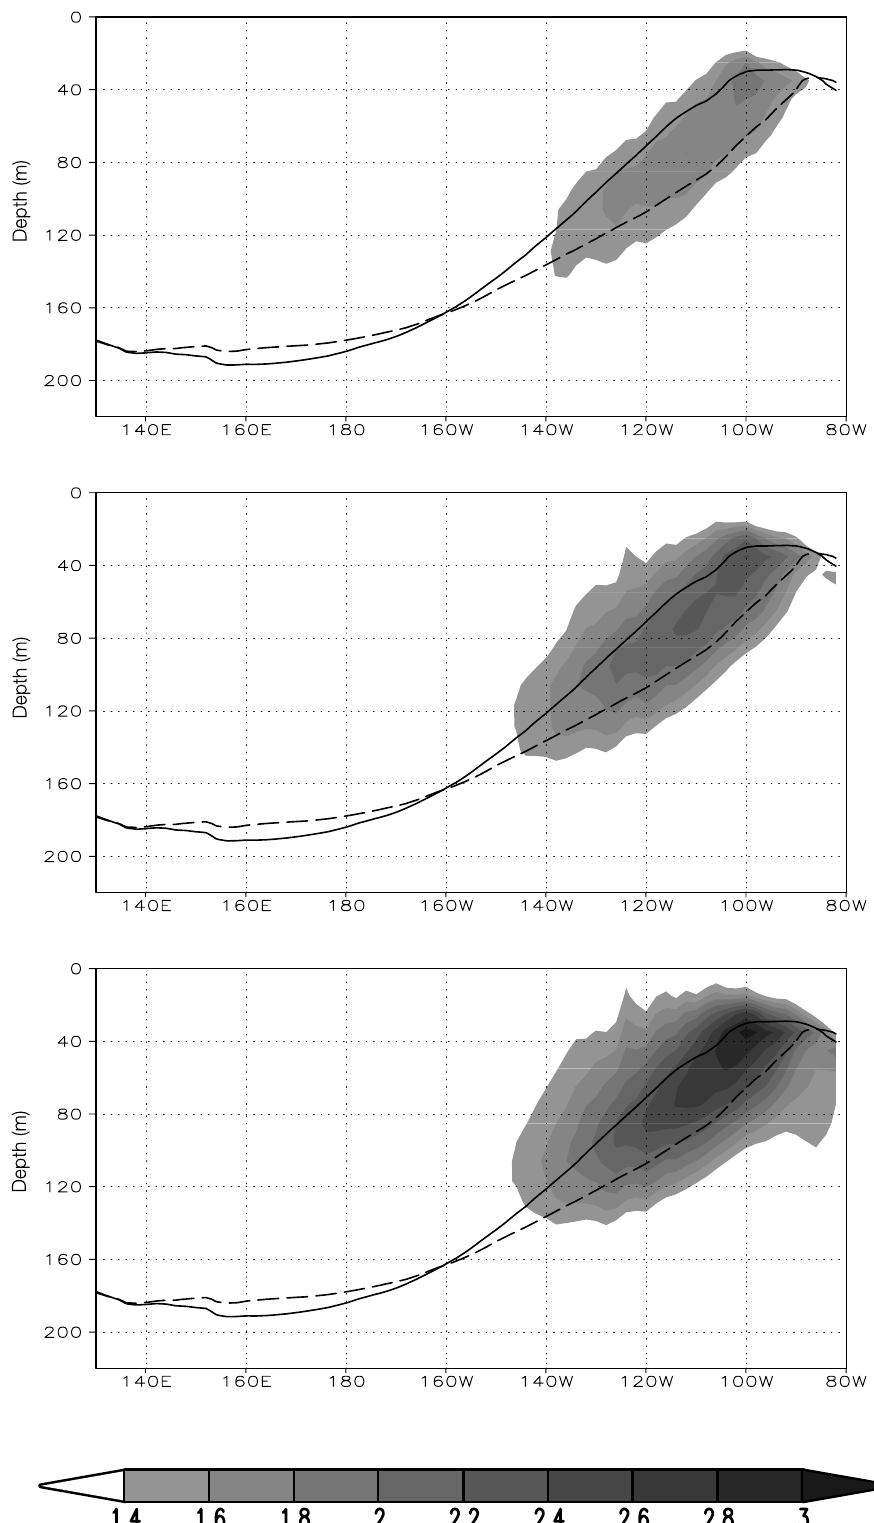
Fig. 5. Vertical section of temperature anomalies ( ° C) along the equatorial Pacific for warm events of type II in months – 6 ( top ), – 5 ( middle ) and – 4 ( bottom ). Superimposed are the climatological 20 ° C isotherm in July (broken line) and September (solid